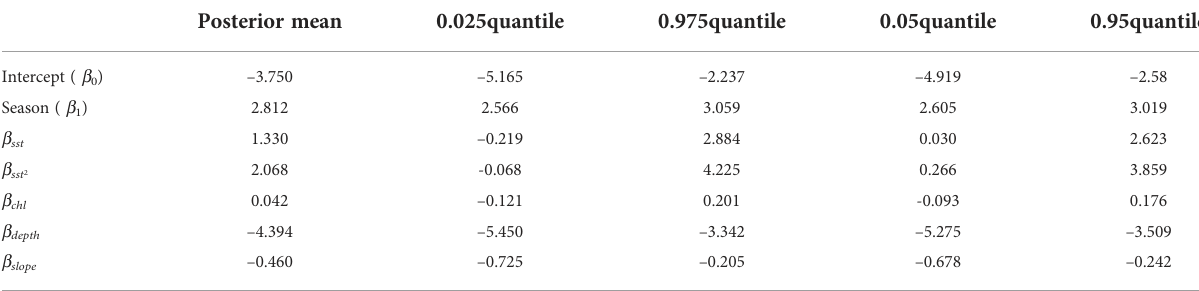
TABLE 2 Estimated posterior means together with 90 and 95% credible interval (CI) for the fi xed effects parameters in Equation